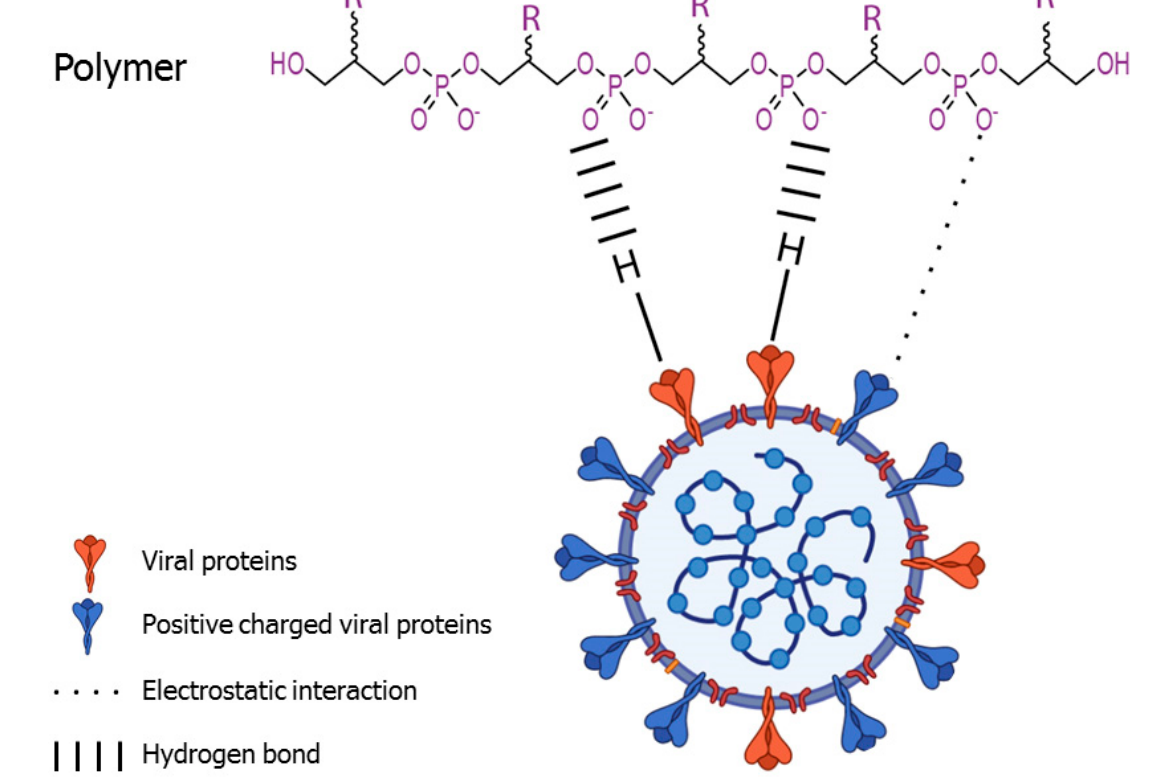
Figure 2. Schematic diagram representing the mechanistic basis of the inhibitory effect of EPSs and other antiviral polyanions on viral adsorption . The figure represents a prototypical polymer interacting with a SARS-CoV-2 virion. The main inhibitory mechanisms include non-covalent and non-specific electrostatic interaction between the negatively charged moieties of the EPSs and the positively charged viral glycoproteins. Viral glycoproteins might also interact with H-bond acceptors of the polymer.